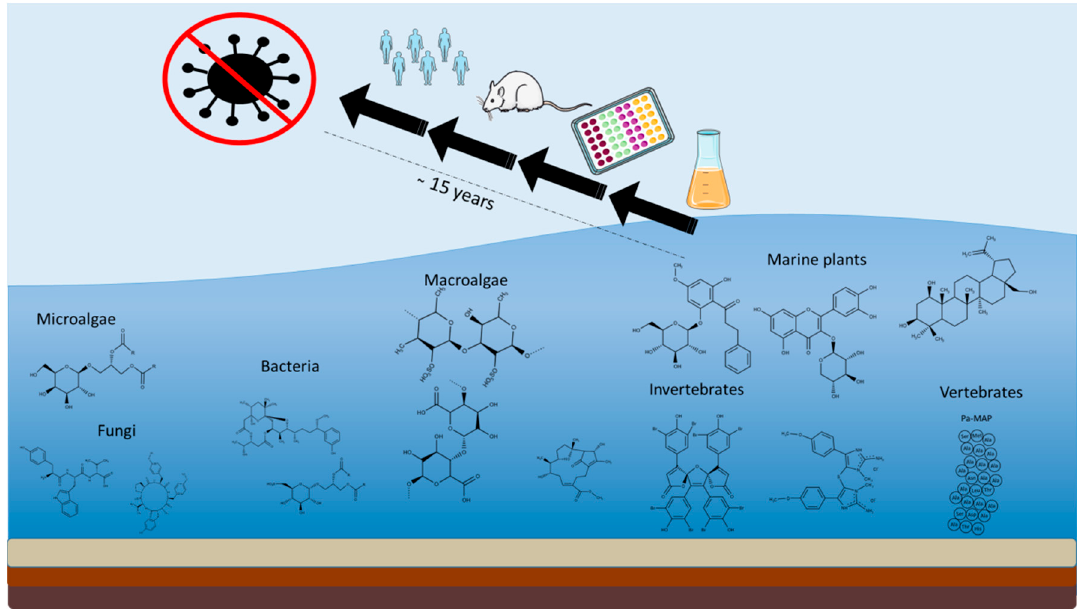
Figure 7. This figure shows time estimates for research and development of new Food and Drug Administration approved antiviral drugs and some examples of antiviral drugs from marine